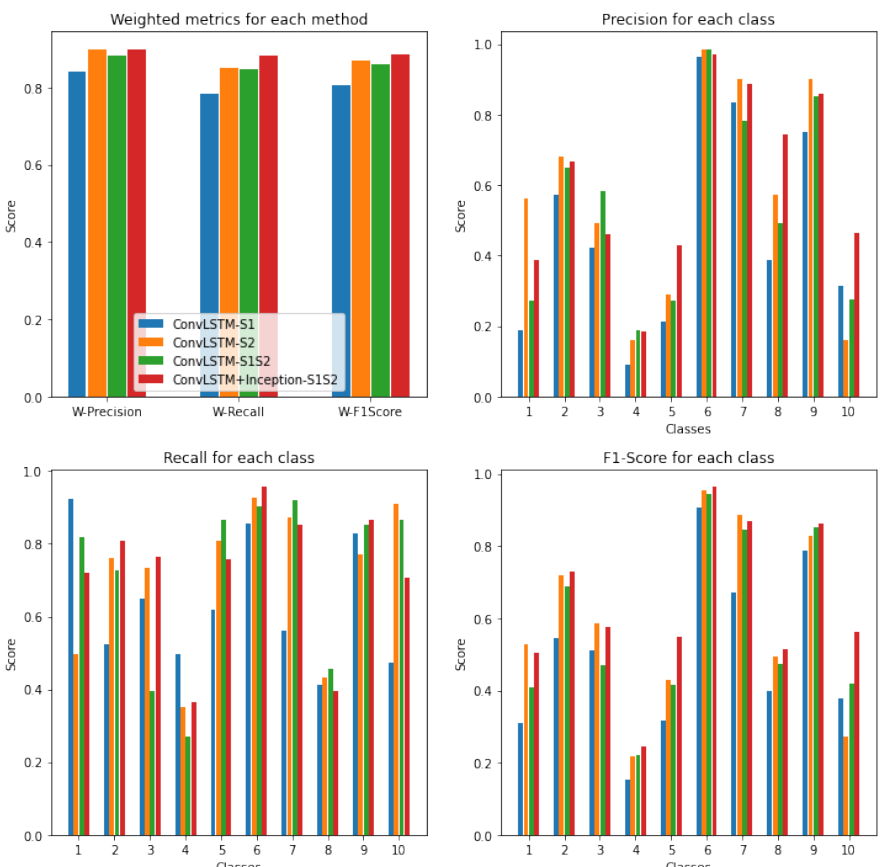
Figure A3. Bar plot results of all methods for the test zone located in the west of the Grand-Est region for 10 semantic